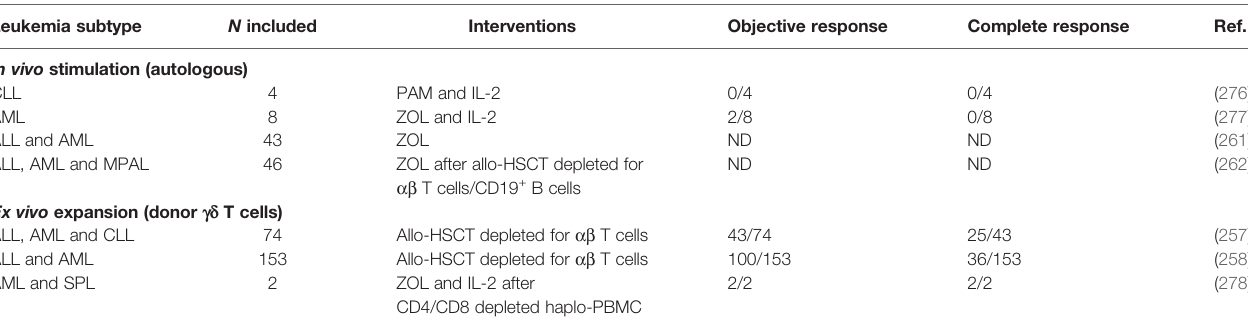
TABLE 2 | Executed clinical trials with gd T cell-based strategies. Leukemia